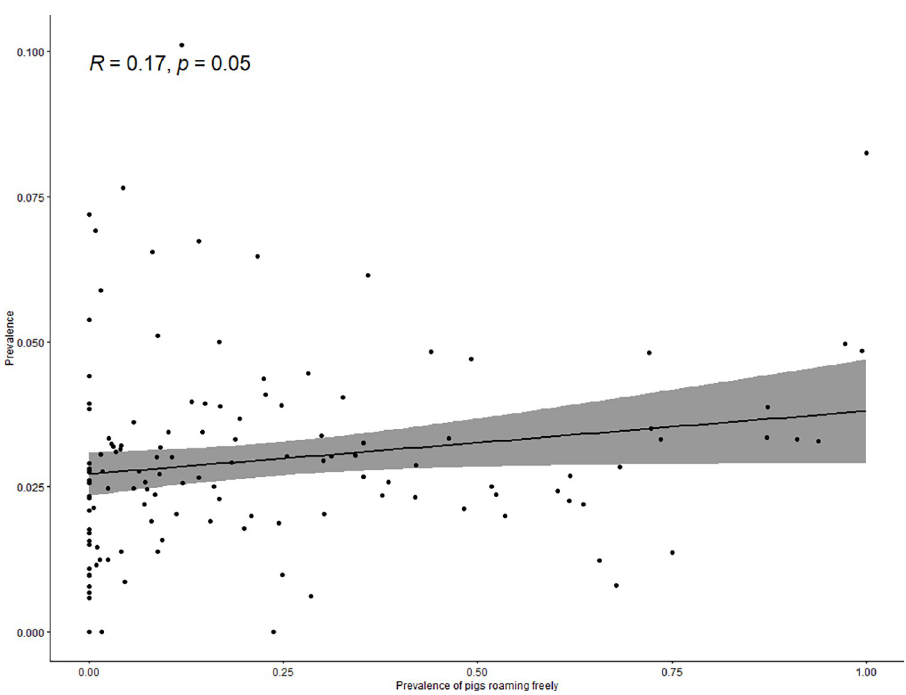
Fig 5. Correlation between proportion of free roaming pigs and village seizure